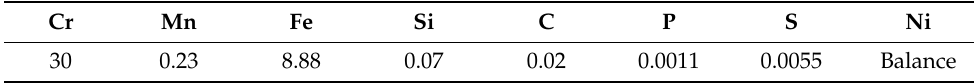
Table 1. Chemical composition of the 690TT used in this work (wt.%).